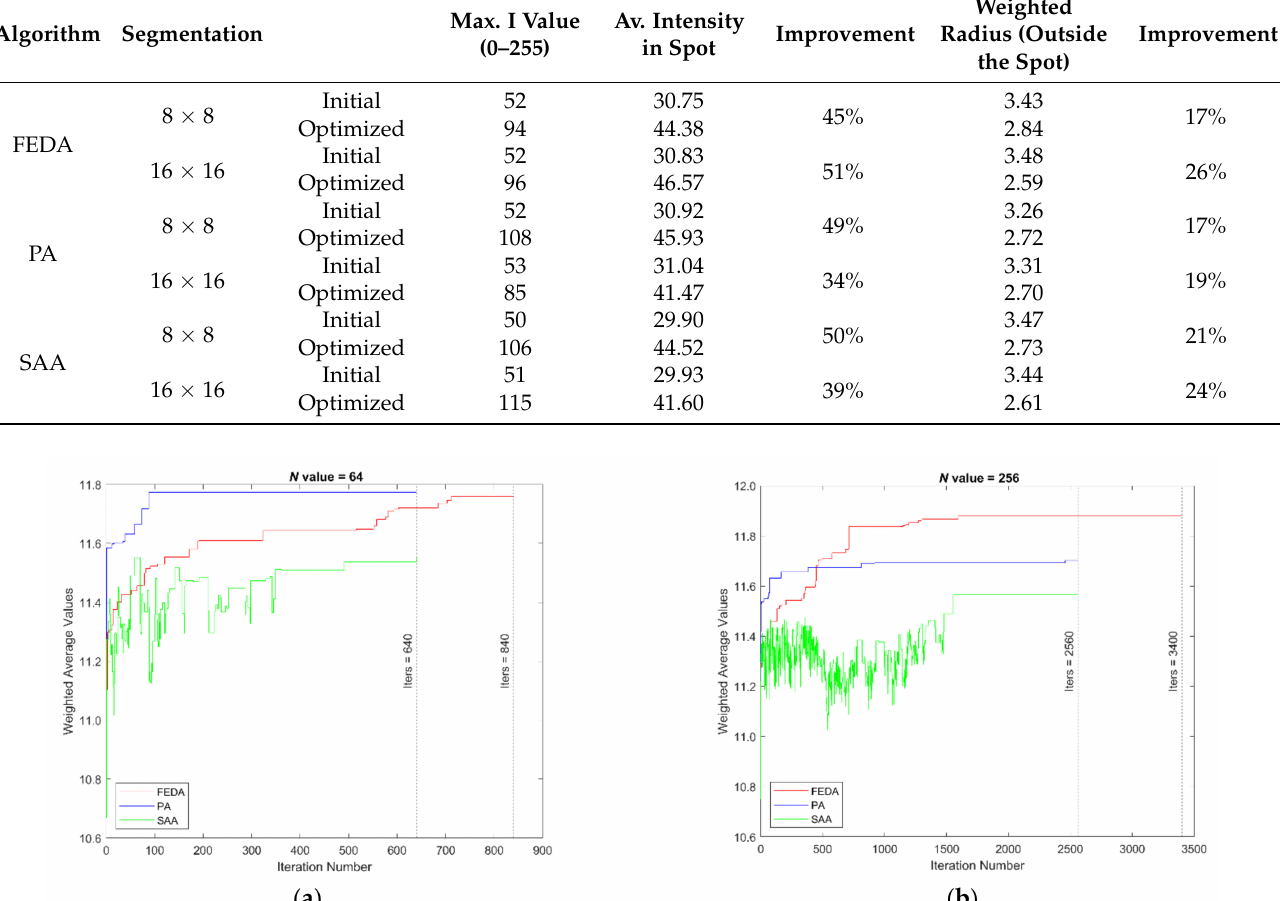
Table 1. Measurements for the weighted average optimization.